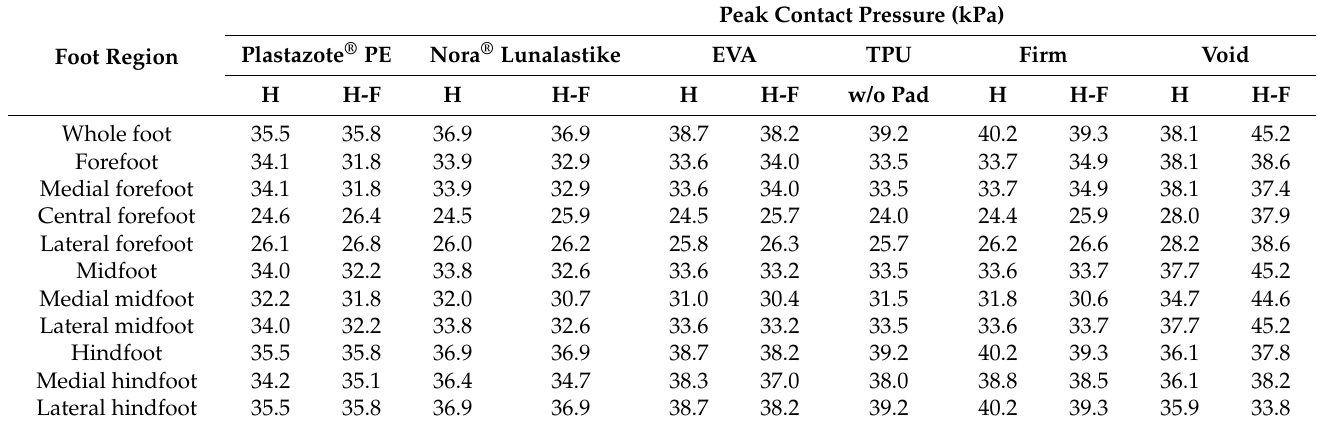
Table 2. Regional peak contact pressure of the foot with heel pad and heel–forefoot pad with varying